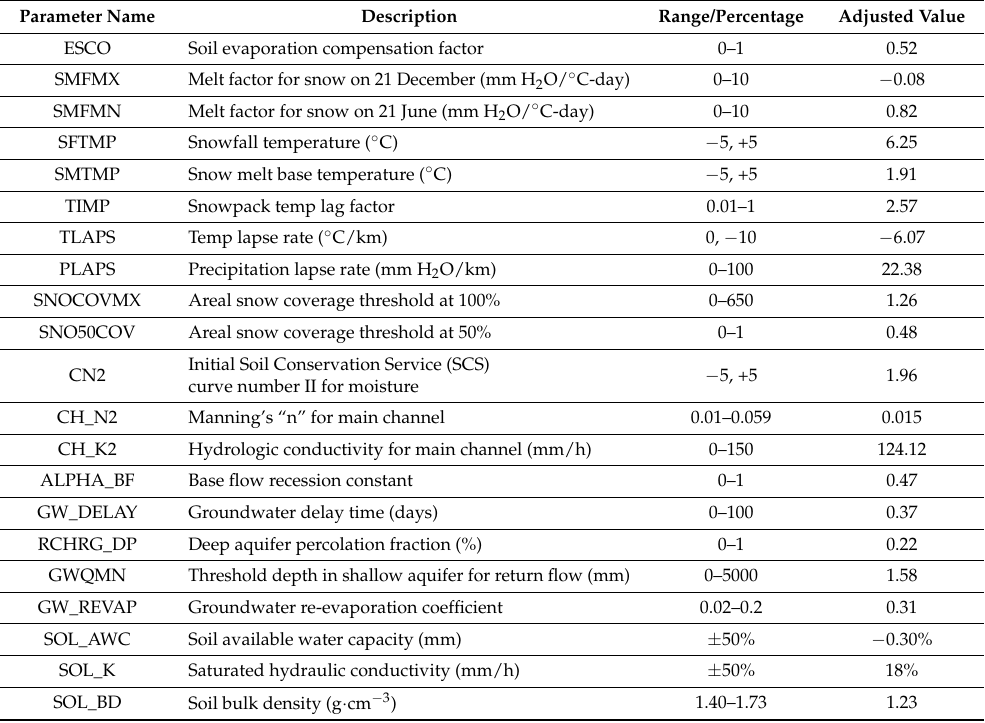
Table 3. SWAT parameters used for calibration and their ranges